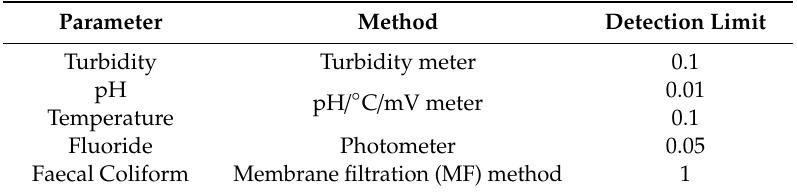
Table 2. Water quality parameters and testing